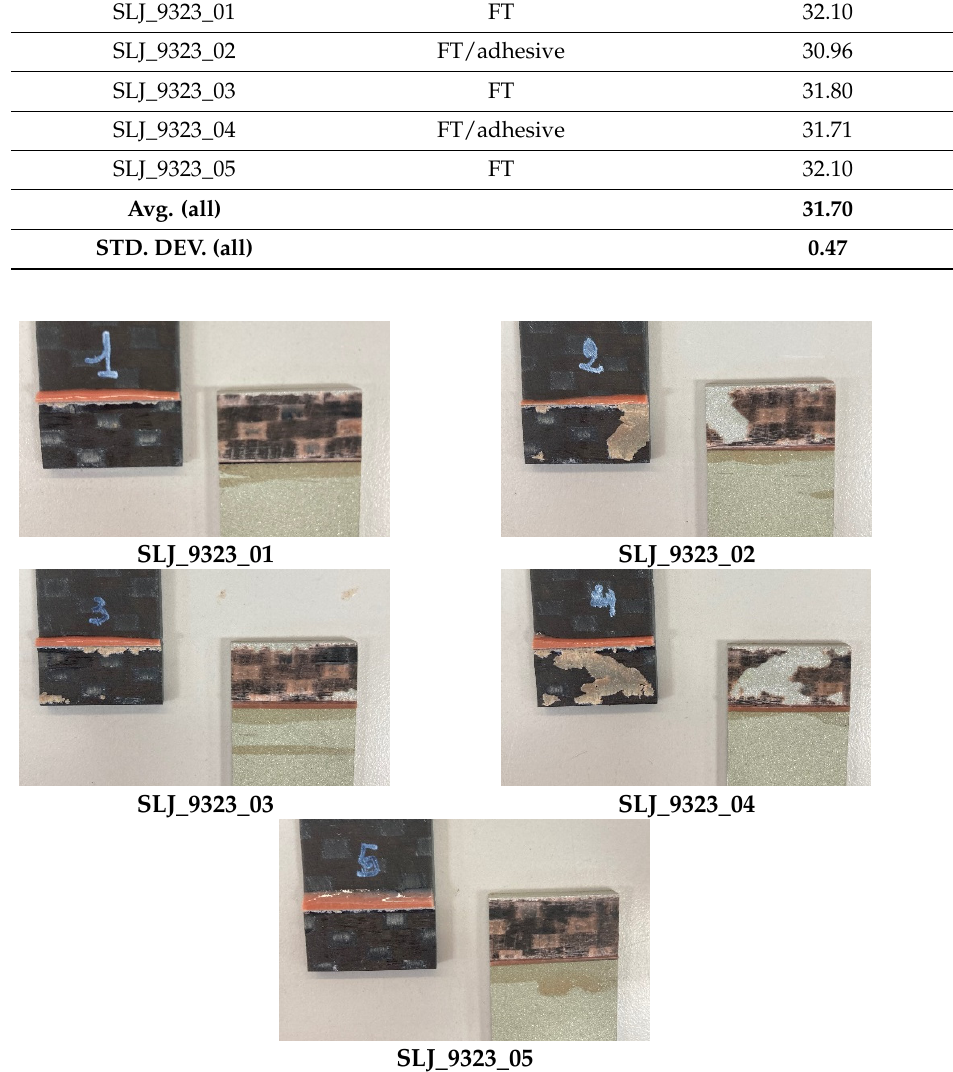
Figure 9. Highlight of failure location in SLJ_9323 tests.